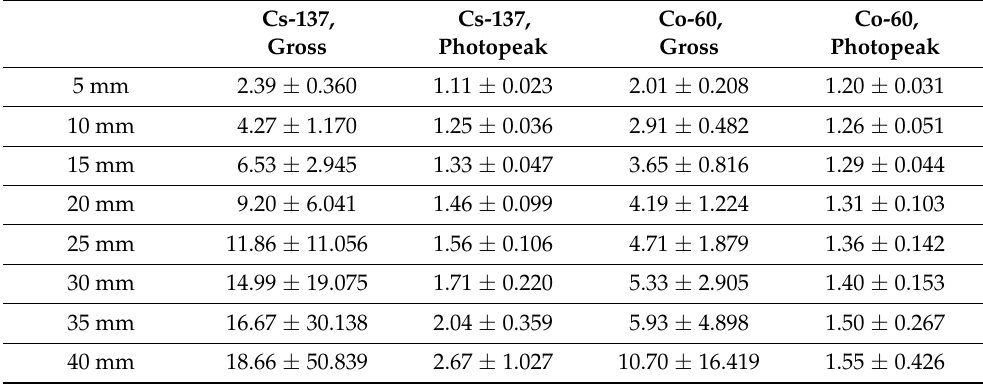
Table 4. Relative build-up factors in water to in air.